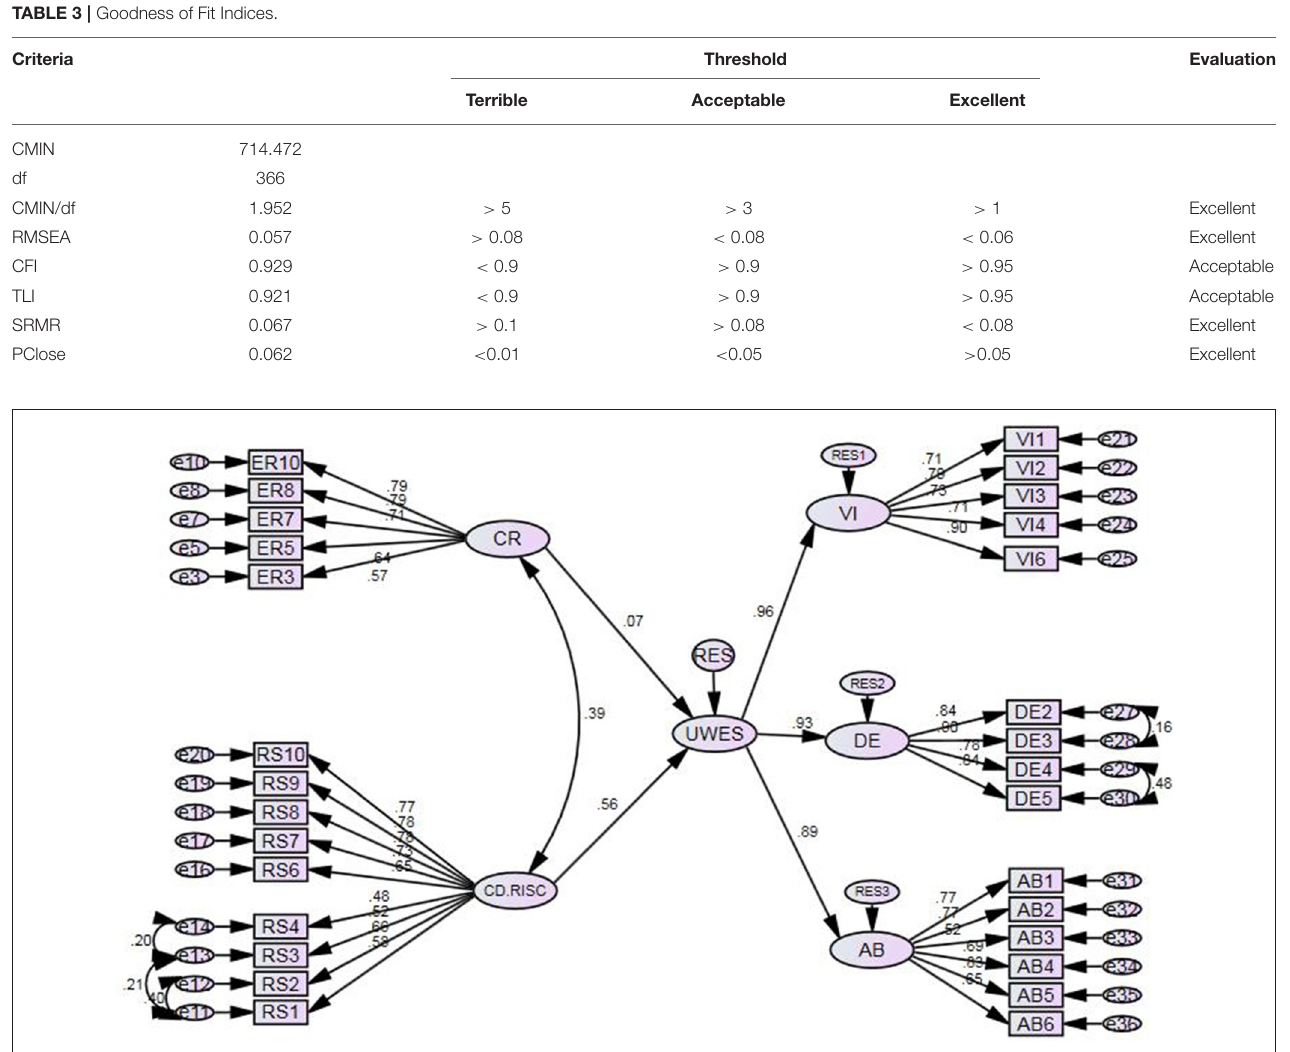
FIGURE 2 | The structural equation model of the interrelationships among Chinese EFL teachers’ resilience, cognitive reappraisal, and work